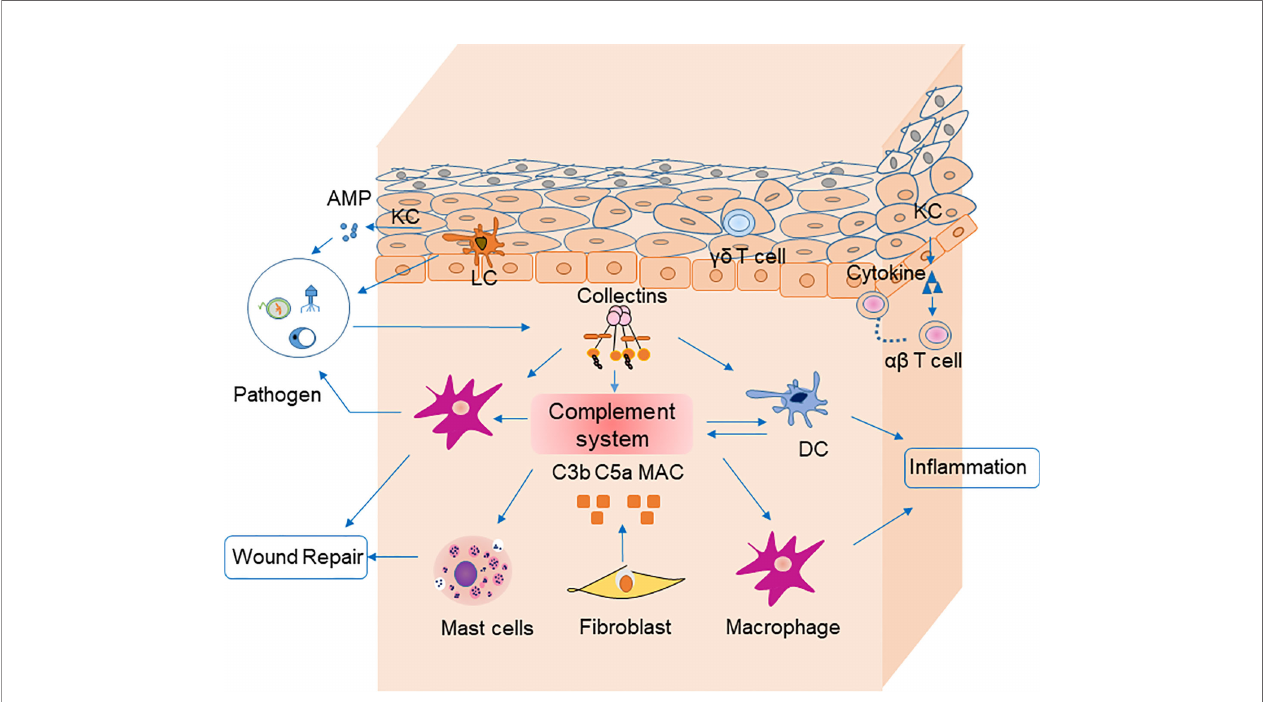
FIGURE 1 | Cells, cytokines, and the complement system are involved in skin homeostasis. Keratinocytes recognize pathogen-associated molecular patterns via pattern recognition receptors on their surfaces, and they secrete antimicrobial peptides. Fibroblasts secrete C3b, C5a, and MAC, which are involved in pathogen clearance by complement. Langerhans cells are antigen-presenting cells for microbial antigens in the epidermis. Dendritic cells secret most components of complement system and mediate together with macrophages pahgocytosis of pathogens via complement receptors (CR1, CR3 and CR4). They could mediate phagocytosis in the clearance of pathogens by receptors (e.g., C3R, C4R) on their surface in turn. Macrophages participate in in fl ammation and wound repair. Receptors for C3a on mast cells can be activated by their ligands to degranulate and secret cytokines including MCP-1 and RANTES, which participate in wound repair. Pathogens stimulate collectins to activate complement system. Collectins may also modulate in fl ammation by macrophages and DCs directly. Keratinocytes recruit ab T cells, and gd T cells to epidermis. AMP, antimicrobial peptide; PRR, pattern recognition receptor; APC, antigen-presenting cell; DC, dendritic